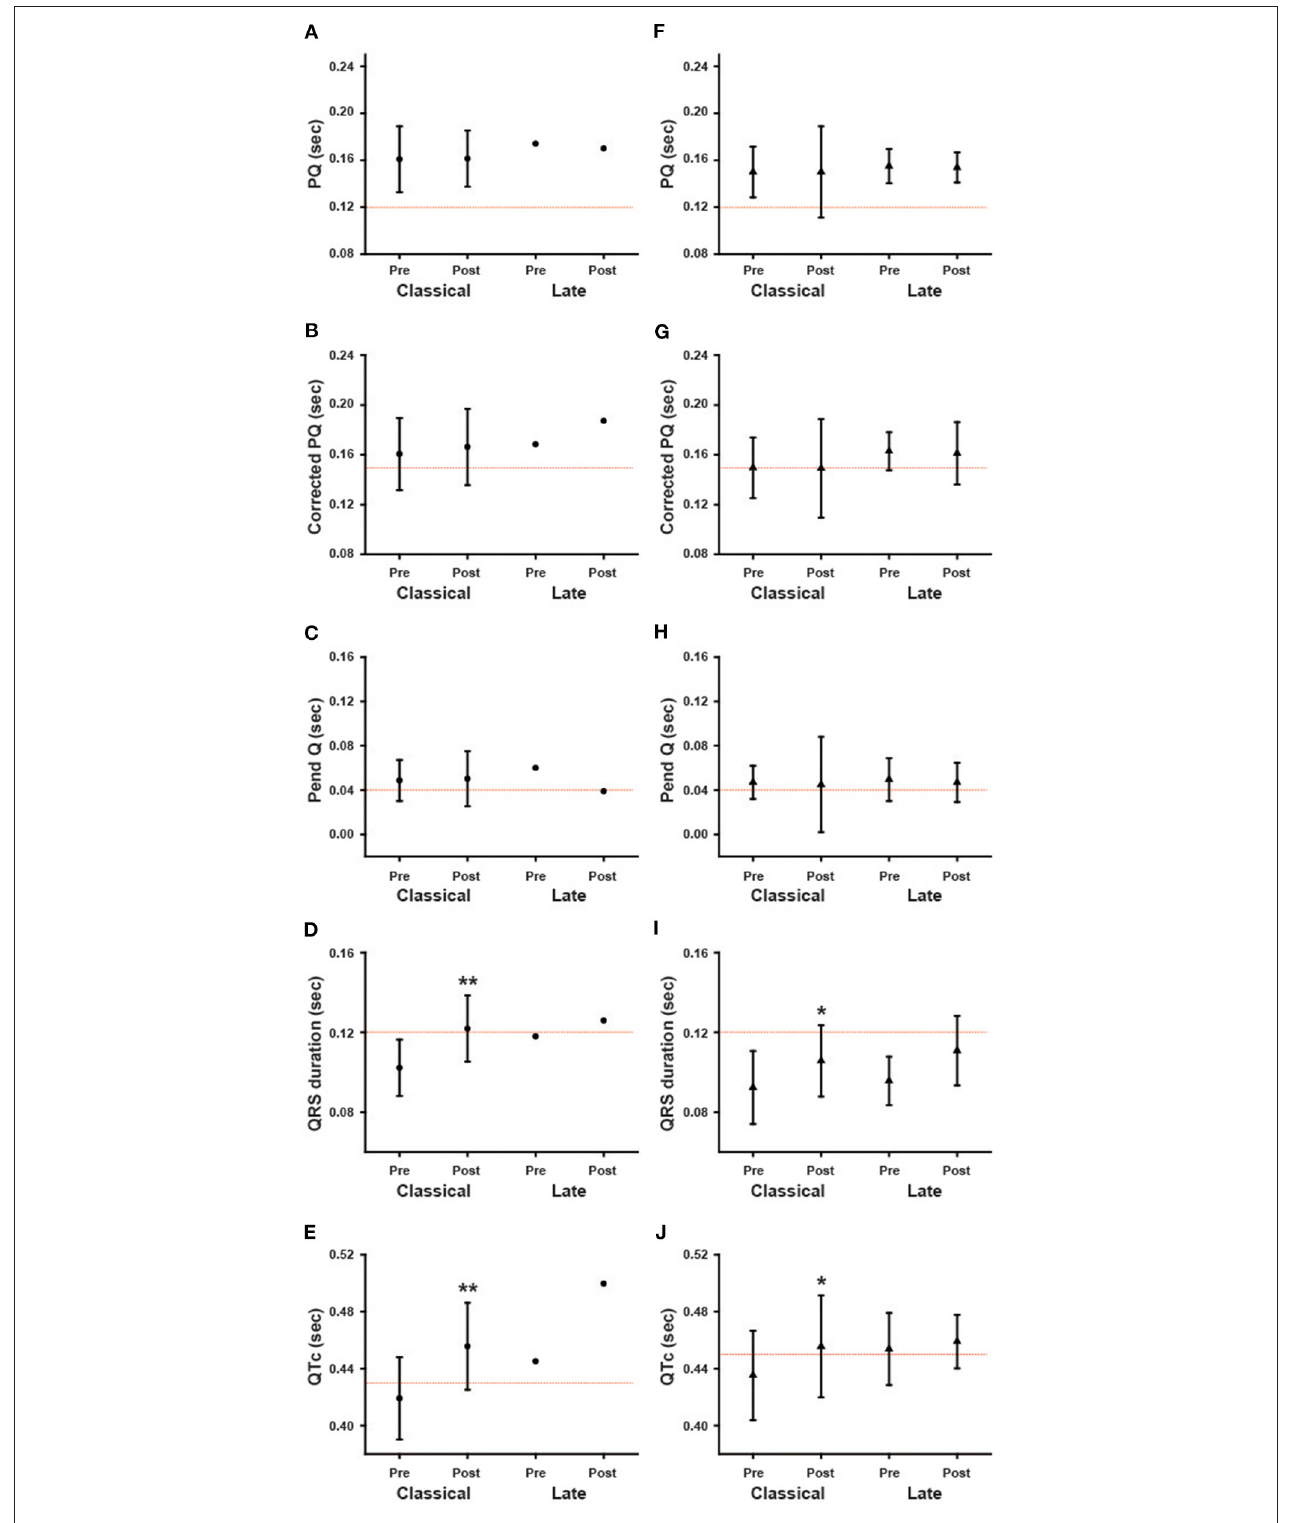
FIGURE 7 | The influence of phenotype/genotype on the changes in various ECG parameters during long-term enzyme replacement therapy. These figures show the average values of ECG parameters before (Pre) and after (Post) long-term enzyme replacement therapy in the patients with classical type (Classical) and late-onset type (Late). The left columns show the results from male patients (A–E) , and the right columns show the results from female patients (F–J) . * p < 0.05, ** p < 0.01 comparison between before (Pre) and after (Post) enzyme replacement therapy.